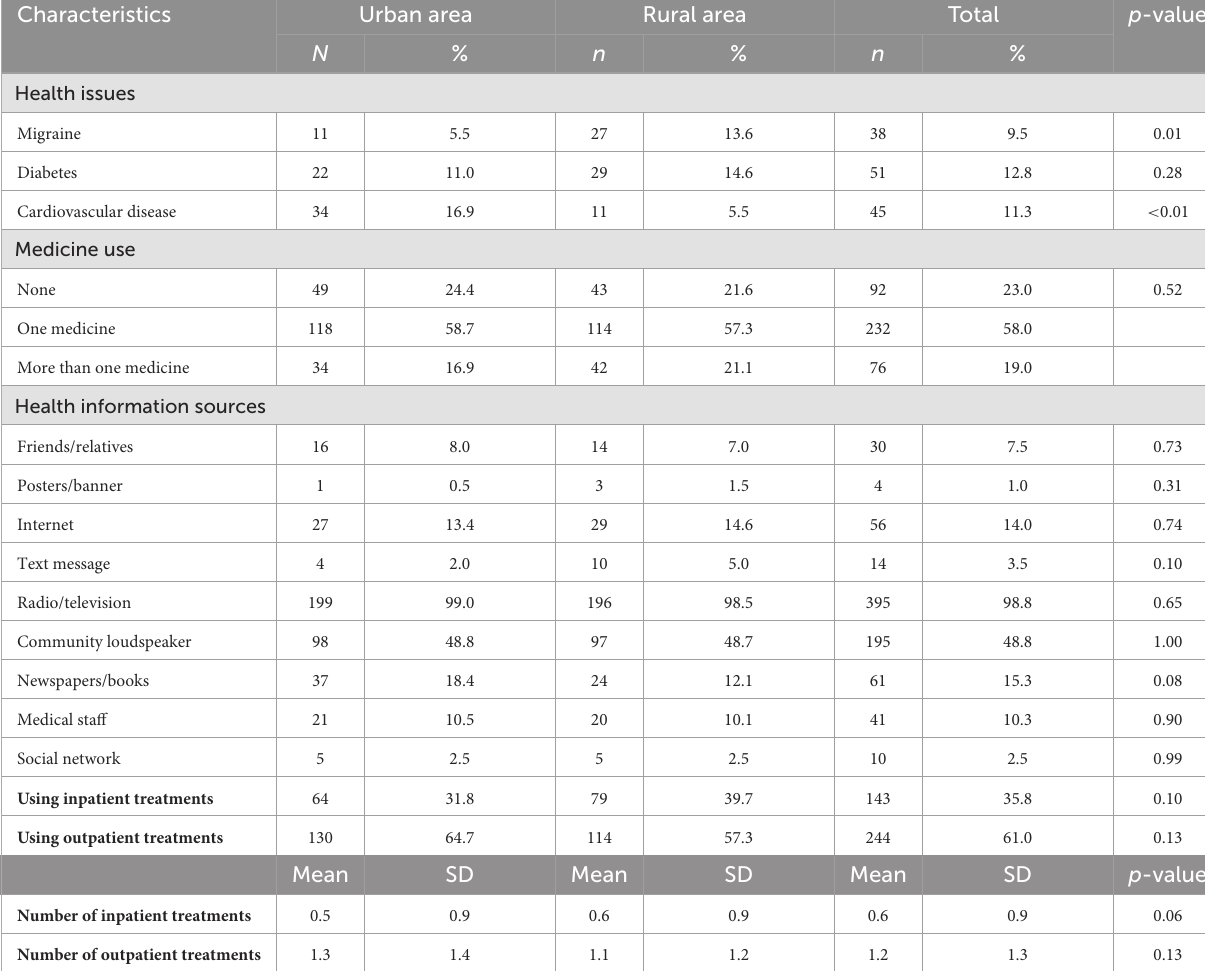
TABLE 2 Health status, health information sources, and health service utilization of participants.